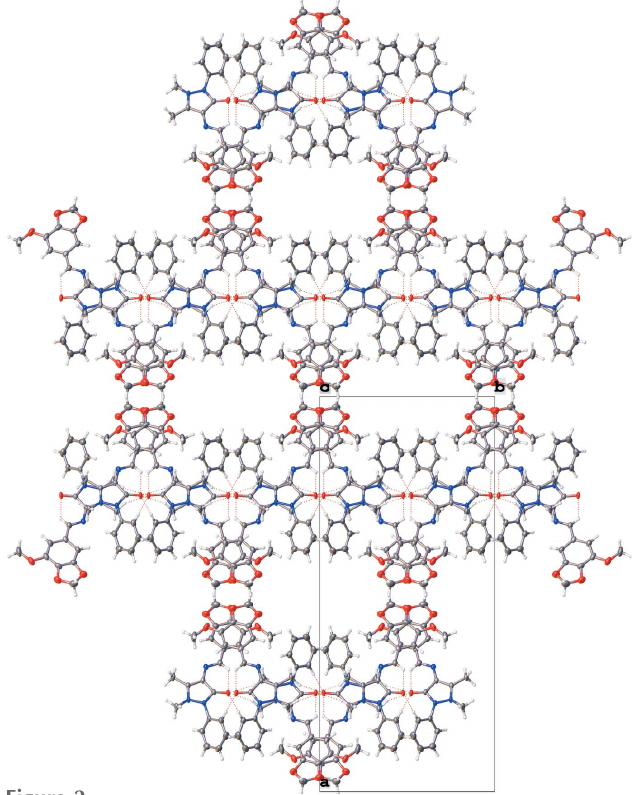
Figure 2 Packing diagram of I as viewed down the c -axis direction. Dashed red lines indicate hydrogen-bonding